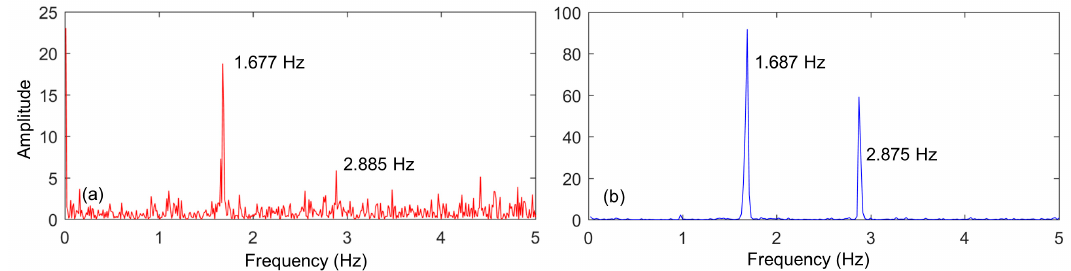
Figure 9. Comparison of FFT-based spectra of two dynamic displacements in the vertical direction: ( a ) spectrum of the dynamic displacements derived from the composite instrument data, and ( b ) the spectrum computed from the accelerometer data.